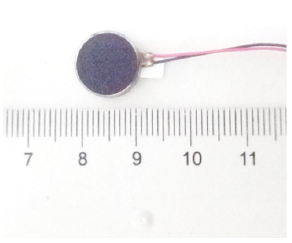
Figure 1. Vibrotactile actuator.